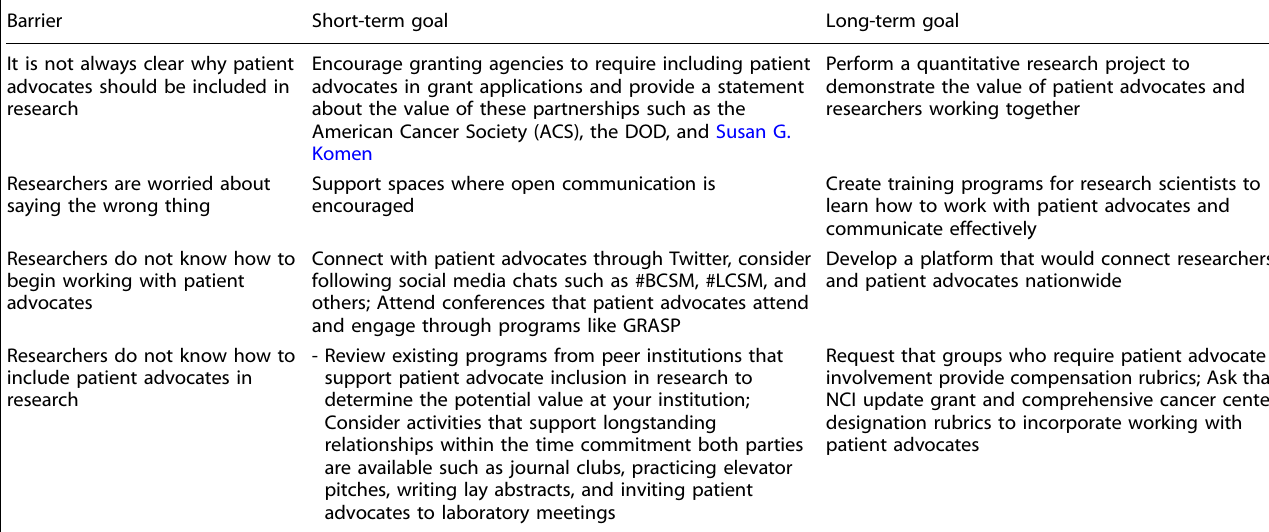
Table 1. Challenges and opportunities for establishing relationships between advocates and